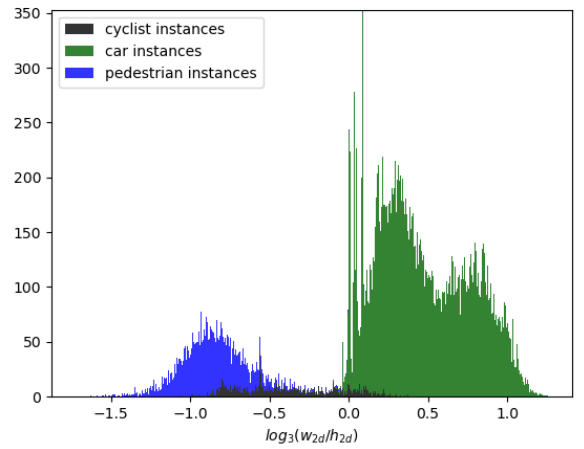
Figure 4. The statistical distribution of the 2D aspect ratios in the KITTI